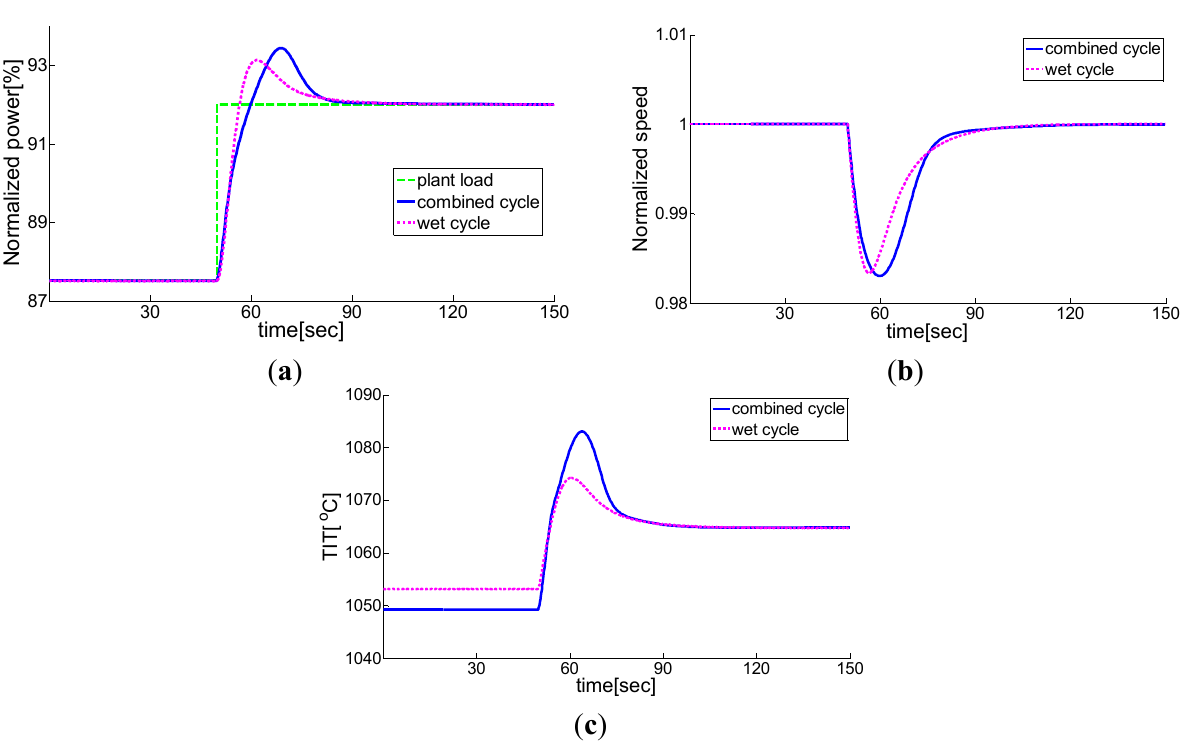
Figure 5. Performance of the combined cycle vs. STIG cycle—4.5% step change load (plant loading from 87.5% to 92% of plant load); ( a ) Normalized power, ( b ) Normalized speed, ( c ) Turbine inlet temperature